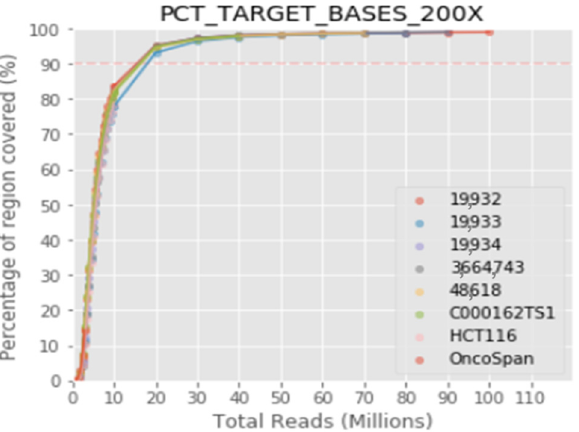
Figure 1. Up to 8 samples can be sequenced in the same run for the NextSeq 500/550 Mid Output v2.5 kit and 24 samples for the NextSeq 500/550 High Output v2.5 kit, ensuring a minimum of 17.5 million passing filter clusters per sample and a coverage of 97.7% with a depth of 200×, or 99.3% with a depth of 100×.